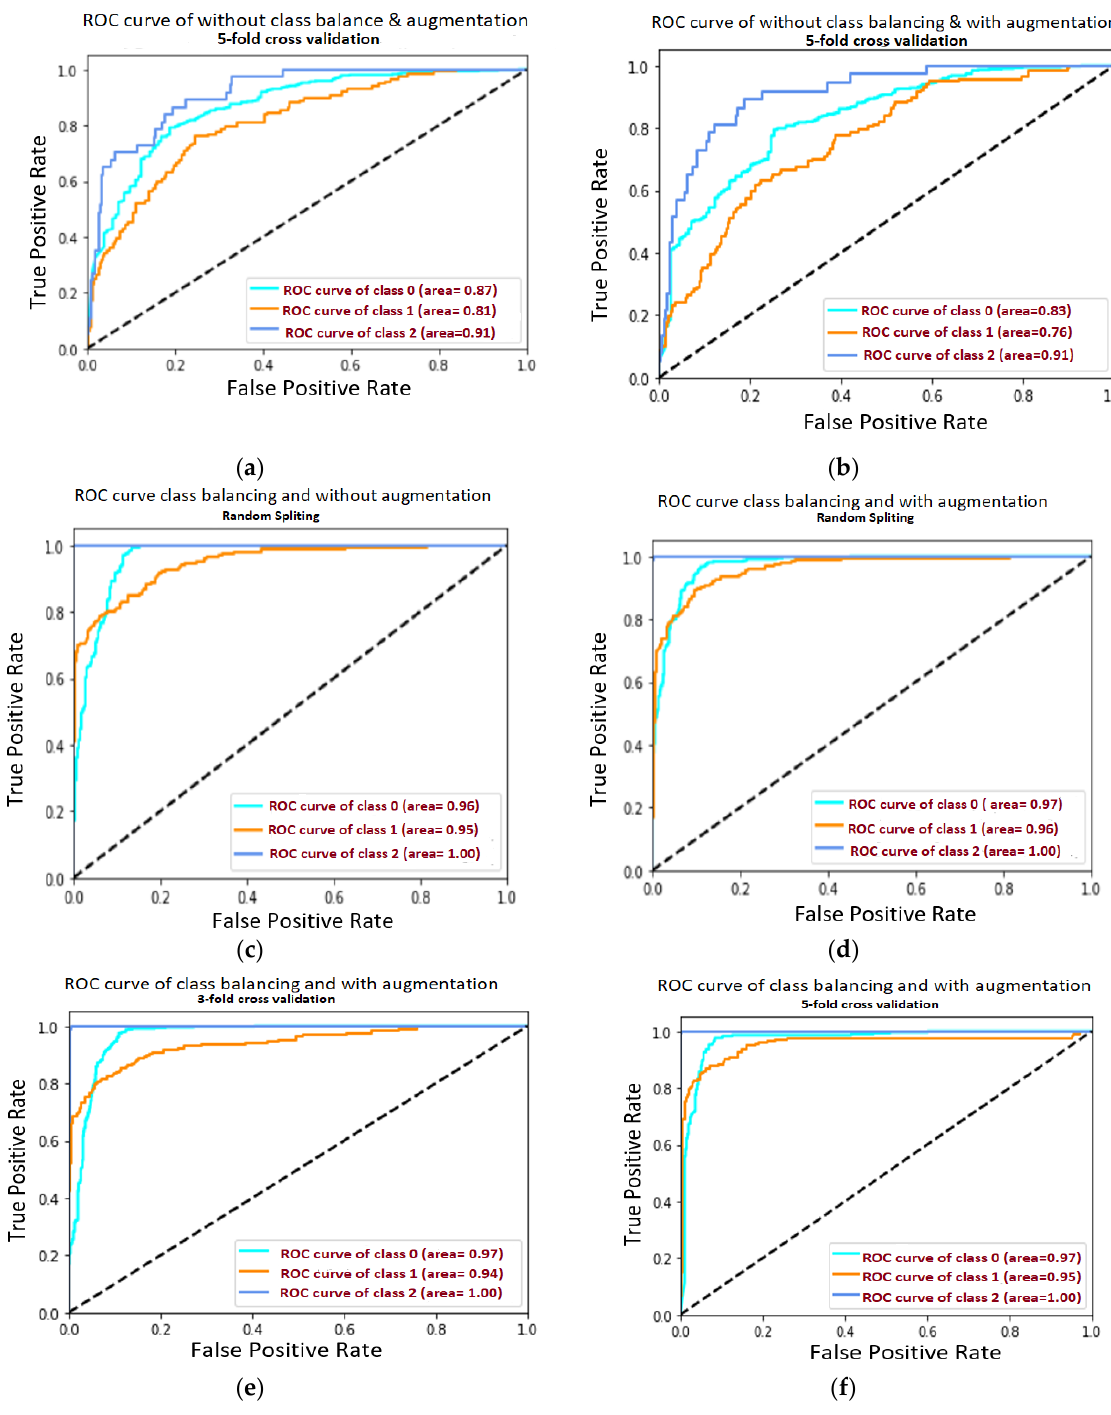
Figure 10. The area under curves of the ResNet CNN Model. ( a ) The area under curve of each class after 5-fold cross- validation in the case without class balancing and without data augmentation where the average AUC is 0.863. ( b ) The area under curve of each class after 5-fold cross-validation in the case without class balancing but with data augmentation of AUC 0.833. ( c ) The area under curve of each class after random train/test split in the case of hybrid class balancing but without data augmentation, the AUC is 0.966. ( d ) The area under curve after random train/test split in the case of hybrid class balancing and also apply data augmentation of AUC 0.973 ( e ) The area under curve 3-fold cross-validation in the case of hybrid class balancing and with data augmentation of AUC 0.966. ( f ) The area under curve after plot 5-fold cross-validation in the case of hybrid class balancing and with data augmentation and AUC is highest 0.98 from all approaches.